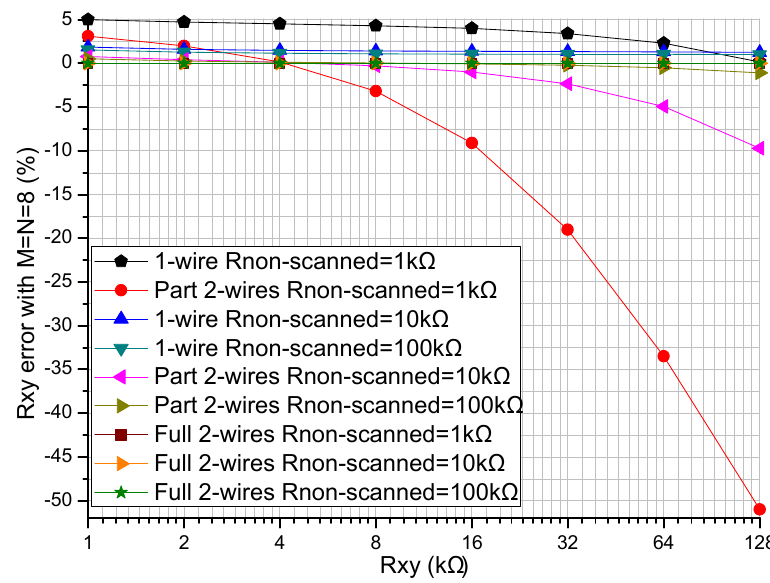
Figure 5. Effect of R non ‐ scanned on the R xy errors in the three circuits where R rwire = R cwire = 5 Ω and M = N = 8. From Figure 5, with R rwire and R cwire fixed at 5 Ω , all R non ‐ scanned s of the three readout circuits at the same resistance of 1 k Ω , 10 k Ω , or 100 k Ω , and R xy varied from 1 k Ω to 128 k Ω , R xy errors in the full